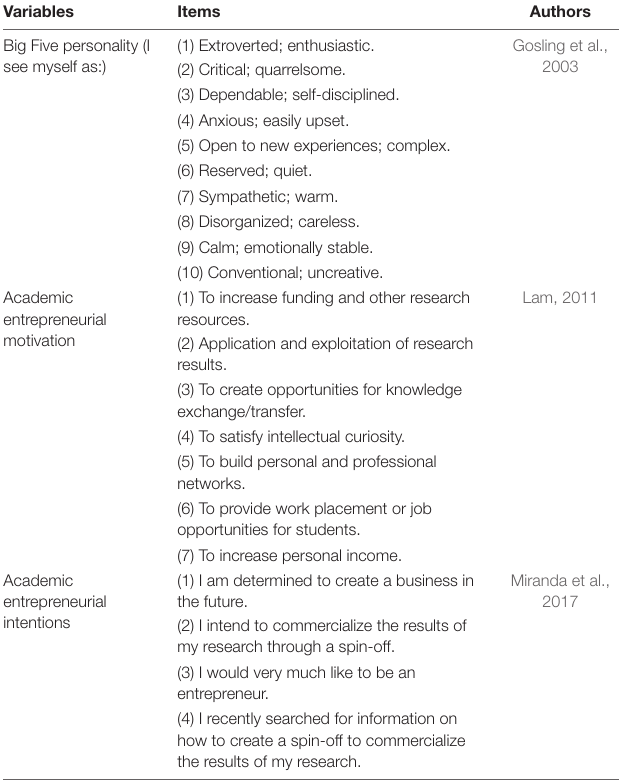
TABLE 1 | Measurement items for each